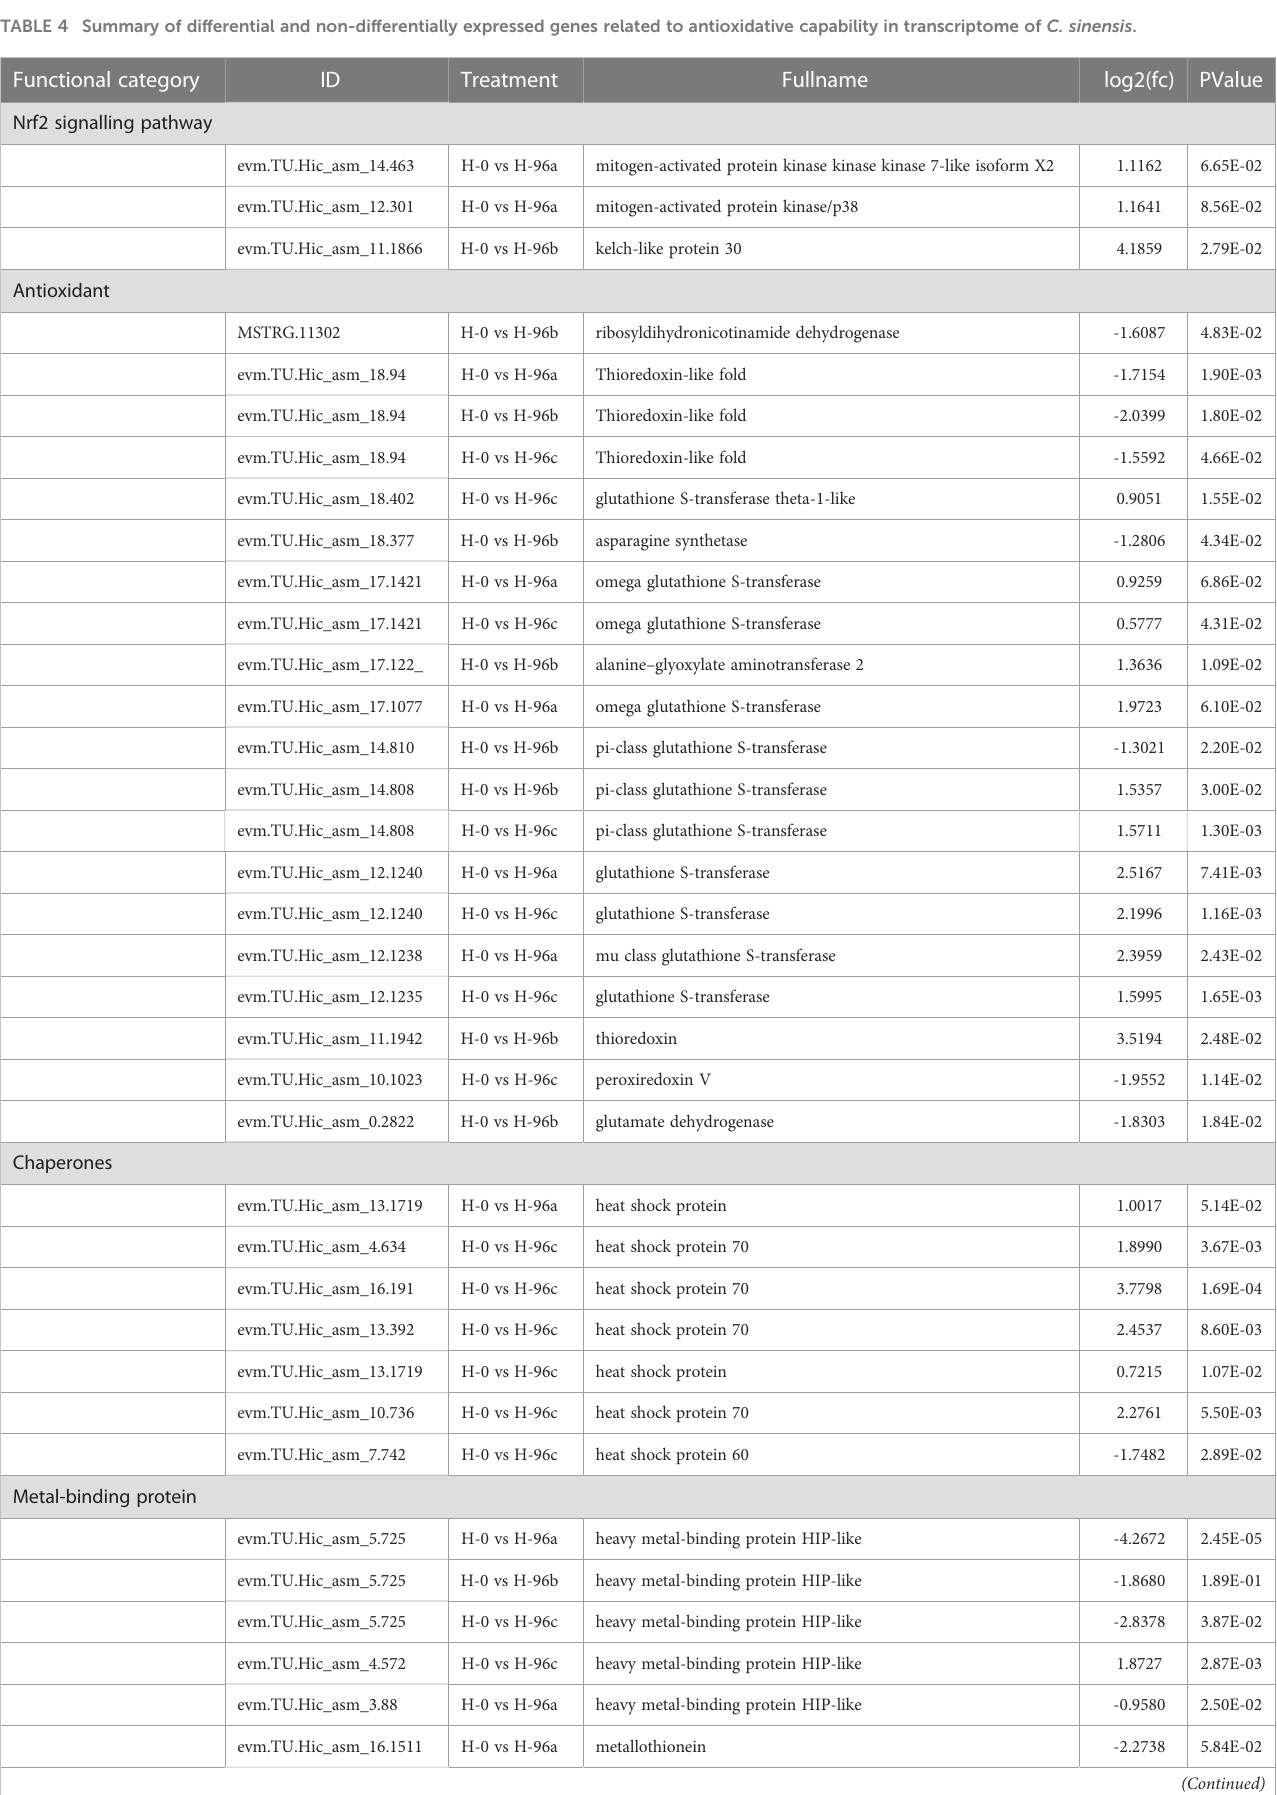
TABLE 4 Summary of differential and non-differentially expressed genes related to antioxidative capability in transcriptome of C. sinensis . Functional